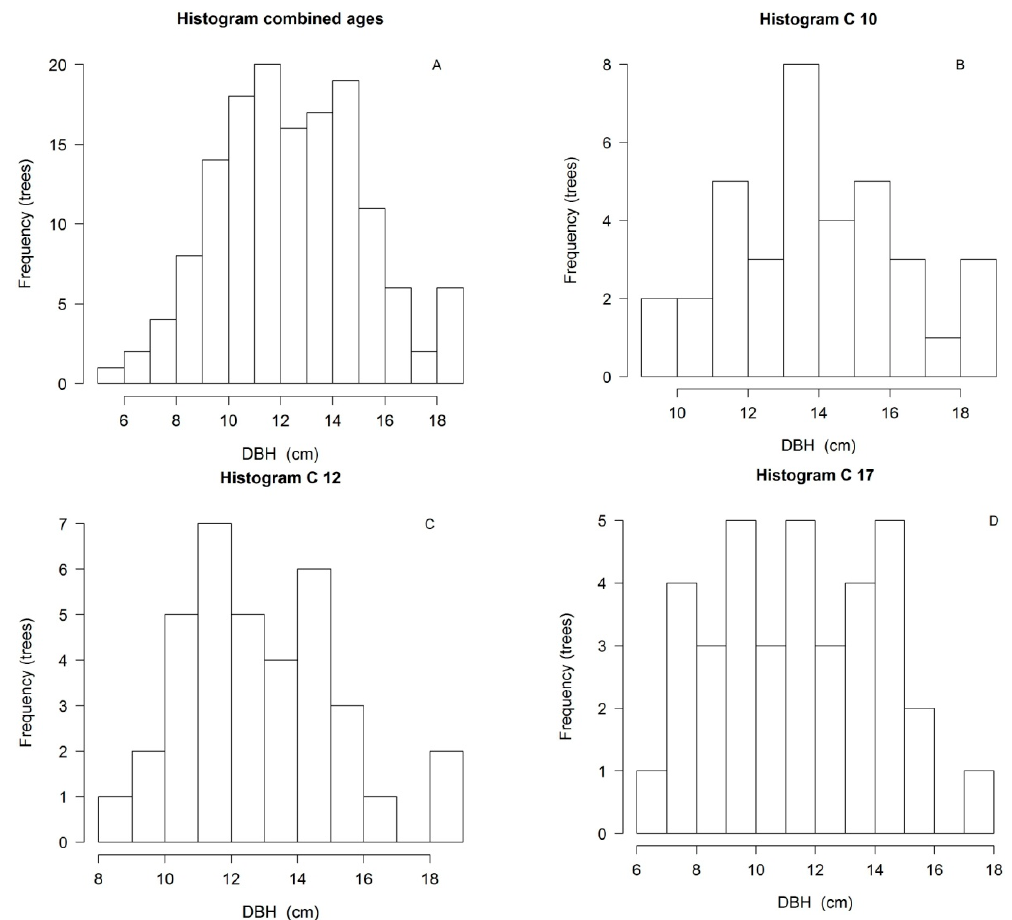
Figure A1. ( A ) Histogram of DBH frequency of trees in three study sites. n = 144 - Shapiro–Wilk normality test, p = 0.586; ( B ) Histogram of DBH frequency of trees in C 10—Shapiro–Wilk normality test, p = 0.741; ( C ) Histogram of DBH frequency of trees in C 12—Shapiro–Wilk normality test, p = 0.735 and; ( D ) Histogram of DBH frequency of trees in C 17—Shapiro–Wilk normality test, p = 0.652.